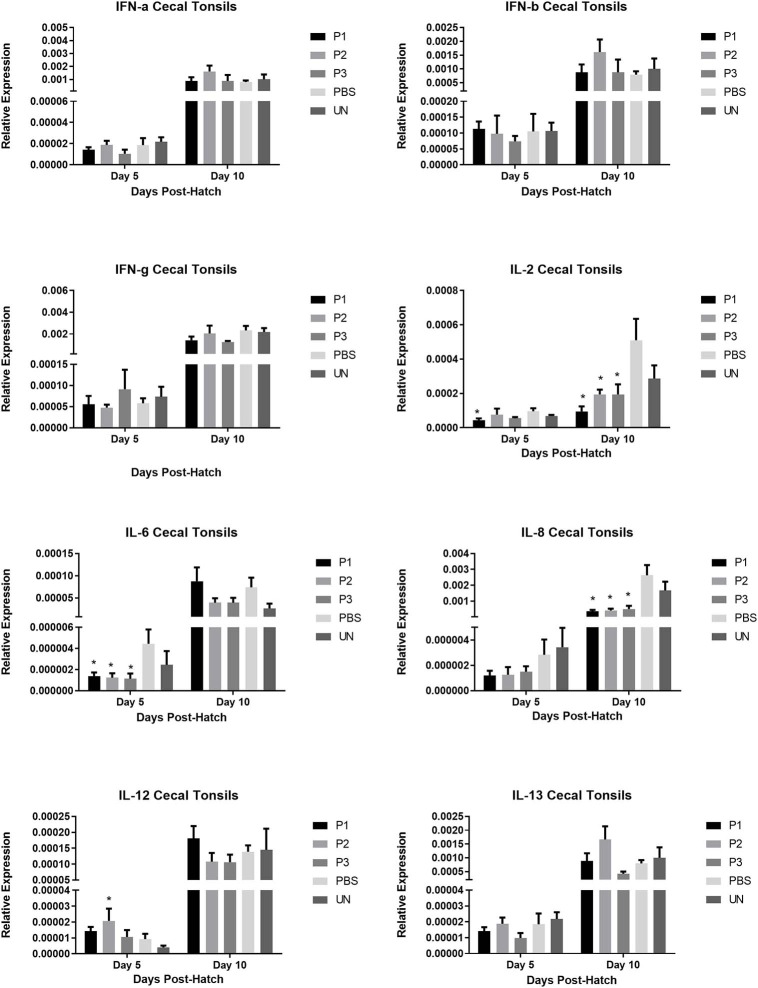
Relative gene expression of IFN-α, IFN-β, IFN-γ, IL-2, IL-6, IL-8, IL-12, and IL-13 in the bursa of Fabricius of chickens on days 5 and 10 post-hatch. Samples collected from 6 birds per treatment. Treatment groups were as follows: P1, P2, and P3 received 1 × 105, 1 × 106, 1 × 107 CFU/egg of a selected mixture of Lactobacillus bacteria (L. salivarius, L. reuteri, L. crispatus, and L. johnsonii) respectively (PBS, phosphate-buffered saline group; and UN, non-injected eggs). The reference gene (Beta-actin) was used for relative gene expression. Statistical significance among treatment groups was calculated using one-way ANOVA followed by Tukey's comparison test. Error bars represent standard errors of the mean. Results were considered statistically significant from the control group if P < 0.05. *Bars with asterisks differ significantly from control (PBS) group.